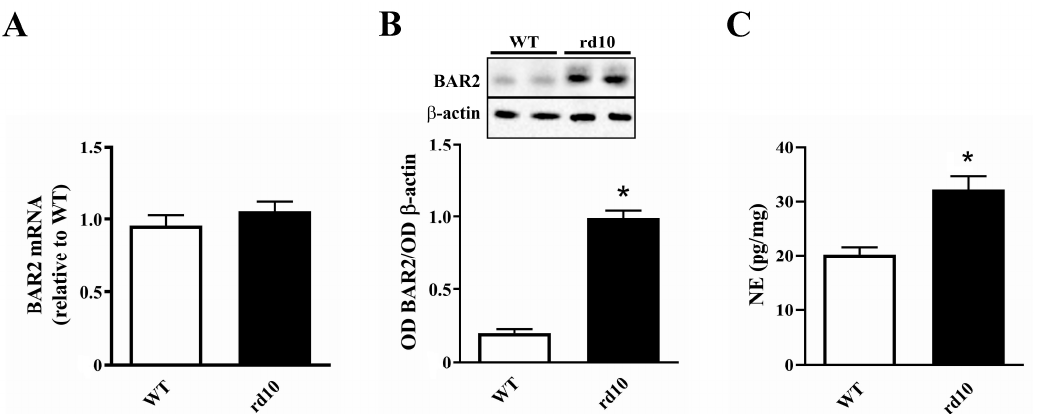
Figure 1. Expression of beta 2 adrenergic receptors (BAR2) and norepinephrine (NE) in the retina of wild type (WT) and rd10 mice. ( A ) Transcript levels of BAR2. ( B ) Protein levels of BAR2. ( C ) Levels of NE. BAR2 transcripts did not differ between WT and rd10 mice while BAR2 protein and NE were both upregulated in rd10 mice ( n = 5 samples per group, each containing 2 retinas from independent mice). * p < 0.001 versus WT (two-tailed Student’s t -test).